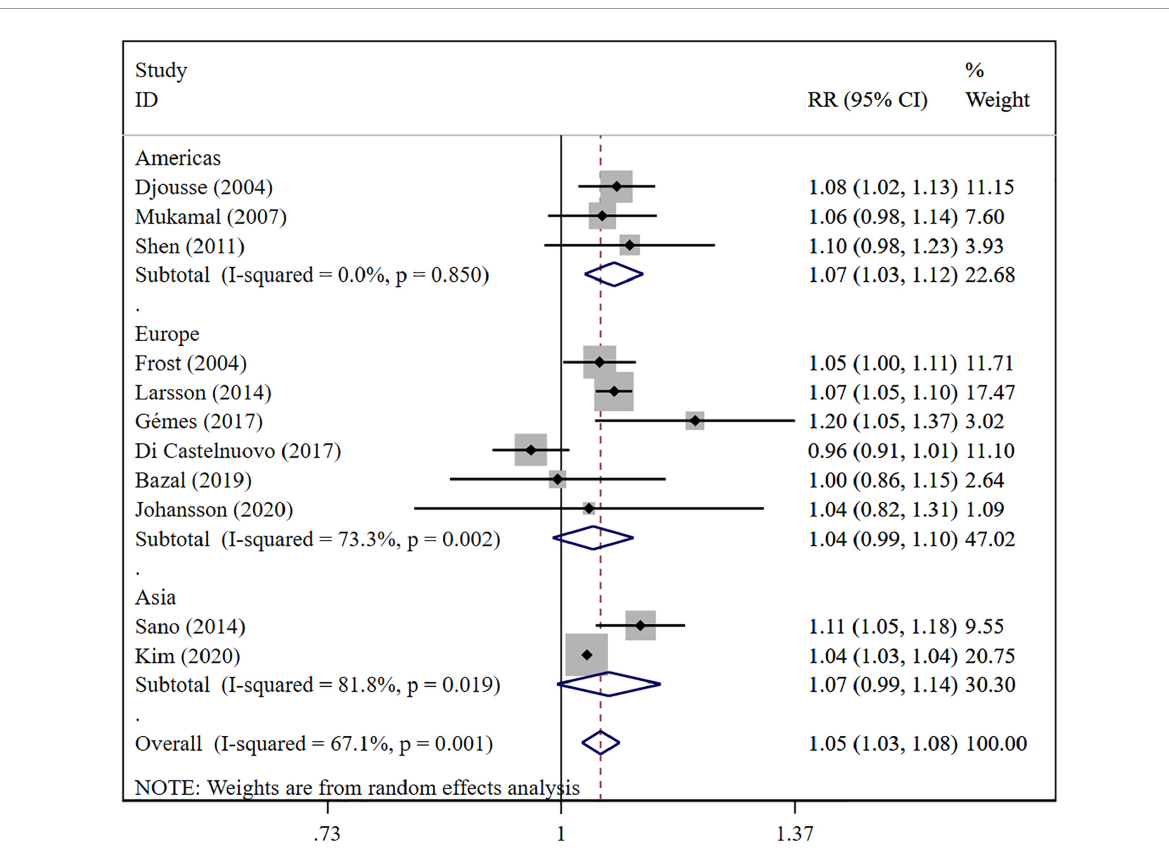
FIGURE7 Subgroup analysis of relative risks of atrial fibrillation per 1 drink/day increment in alcohol consumption in different